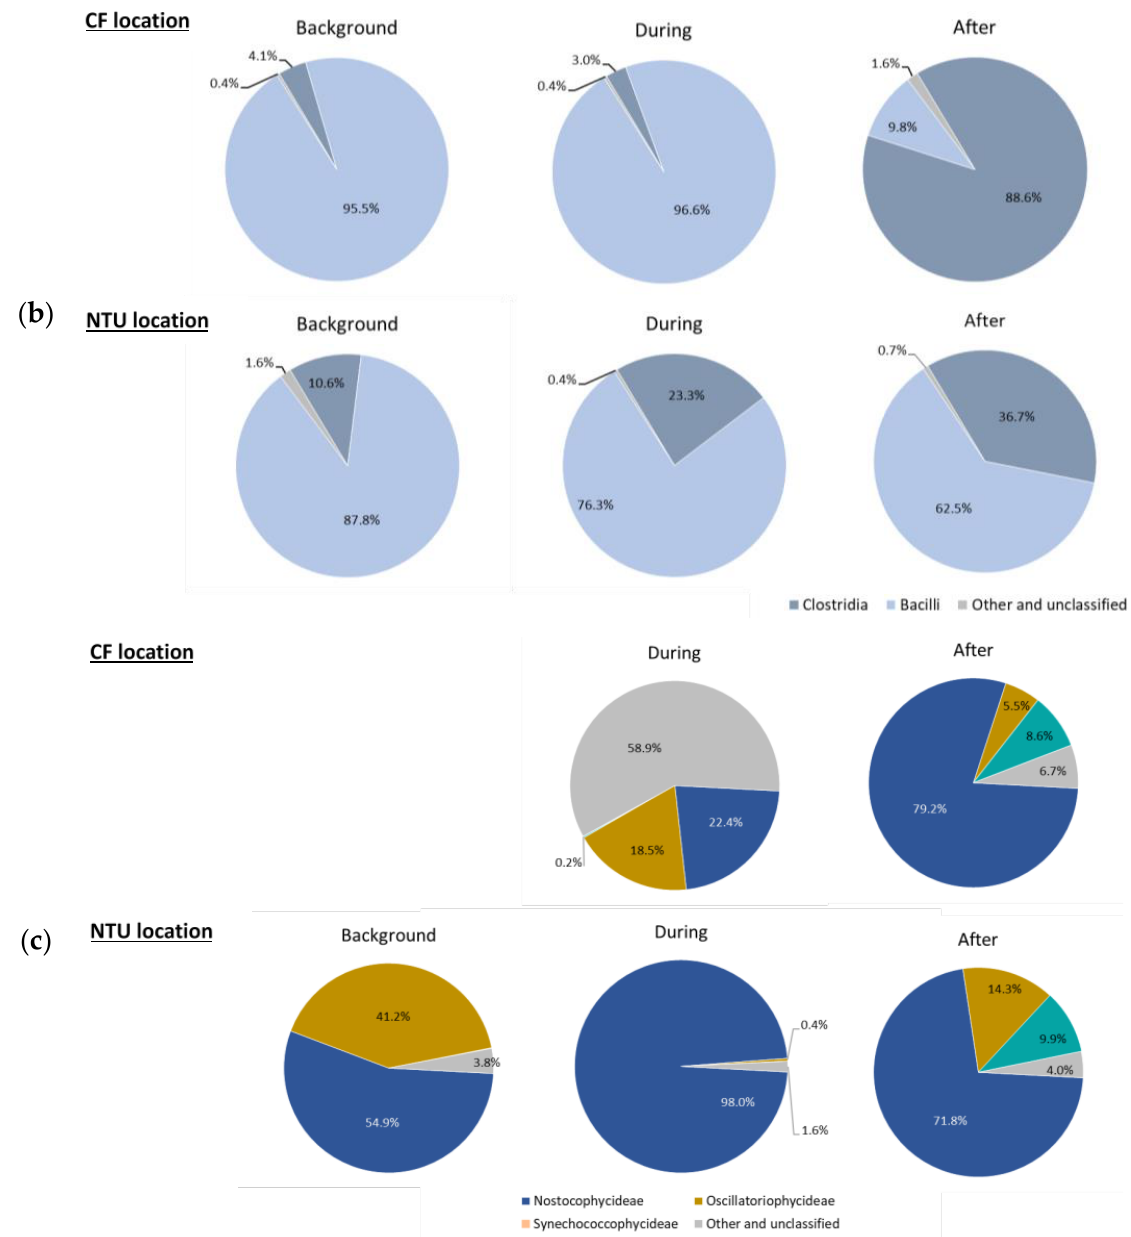
Figure 3. Classes of Proteobacteria ( a ), Firmicutes ( b ); and Cyanobacteria ( c ) on background days as well as during and after the FP1 (frontal pollution case 1). The classes with the relative abundance of less than 1% were not listed.